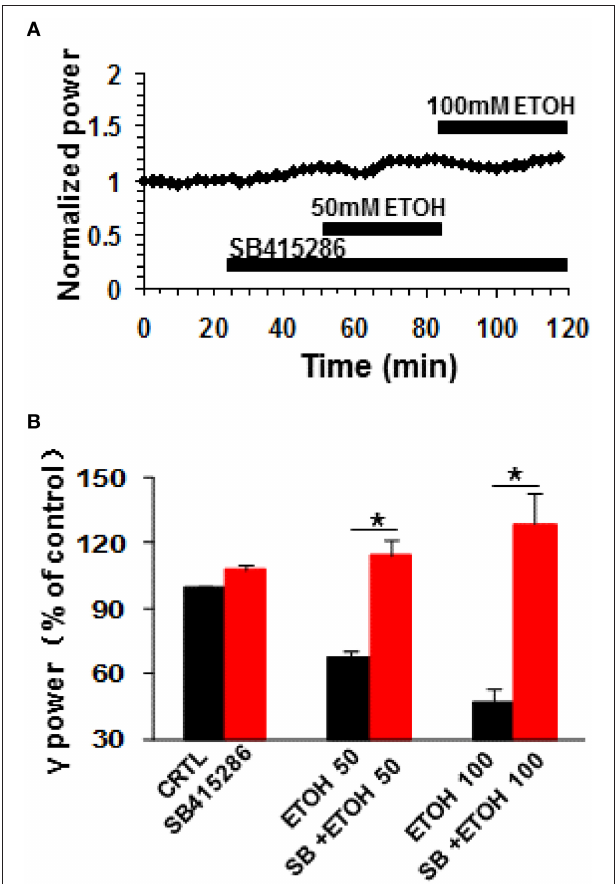
FIGURE 5 | The effects of GSK3 β inhibitor on ethanol-induced suppression of γ oscillations. (A) Example of the effect of ethanol on γ power in the presence of the GSK3 β inhibitor SB415286 (5 µ M). Details as in Figure 2A . (B) γ power as % of baseline for SB415286, 50 and 100mM ethanol ( n = 9). Details as in Figure 2B . * P <